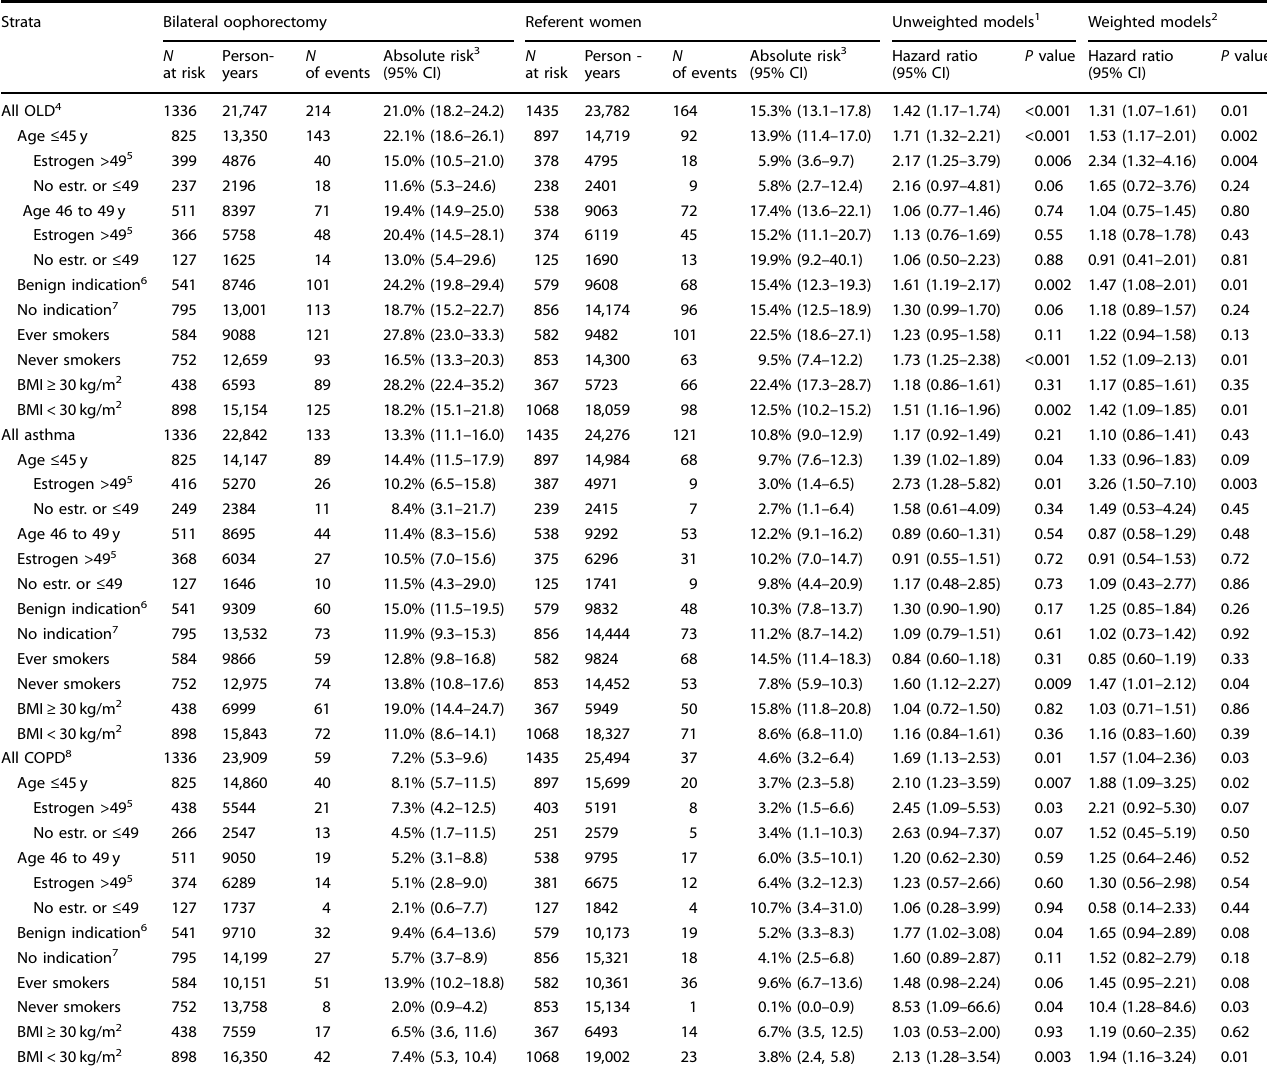
Table 3. Cumulative incidence of all obstructive lung disease, all asthma, and all chronic obstructive pulmonary disease overall and in strata by age at oophorectomy, estrogen therapy, surgical indication, cigarette smoking, and body mass index. Strata Bilateral